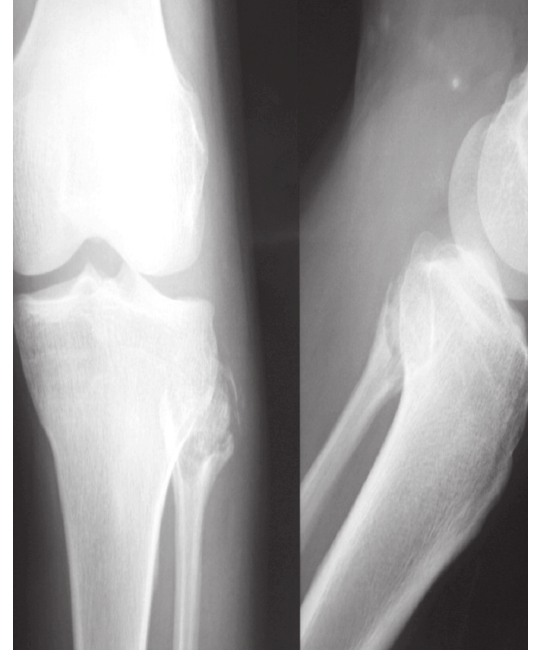
Figure 1. X-ray Right Knee AP/Lat. View-Expansile